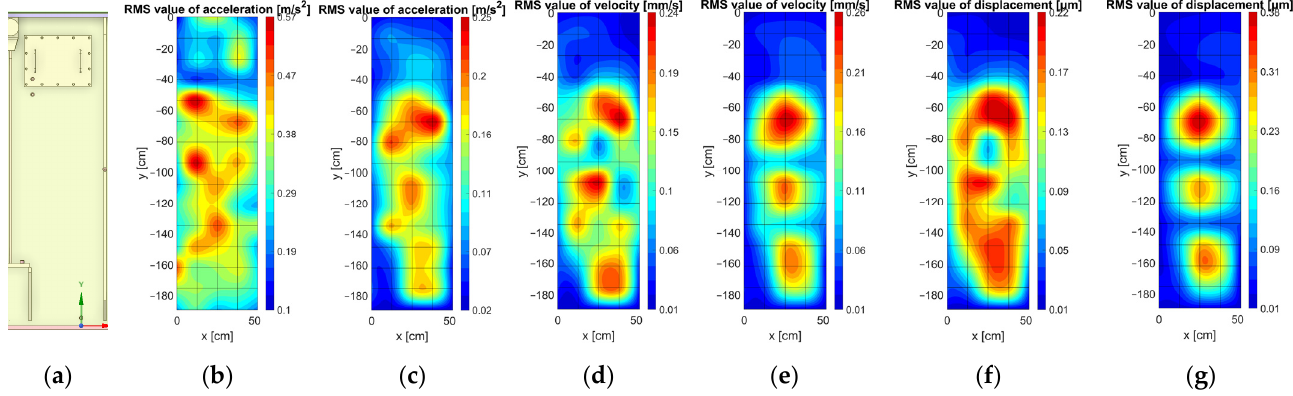
Figure 7. ( a ) CAD model of the surface 5 of the transformer experimental model, and visualization of RMS values of the vibration acceleration, velocity, and displacement on the surface 5 using: ( b , d , f ) power converter as the source and ( c , e , g ) regulating transformer as a source.